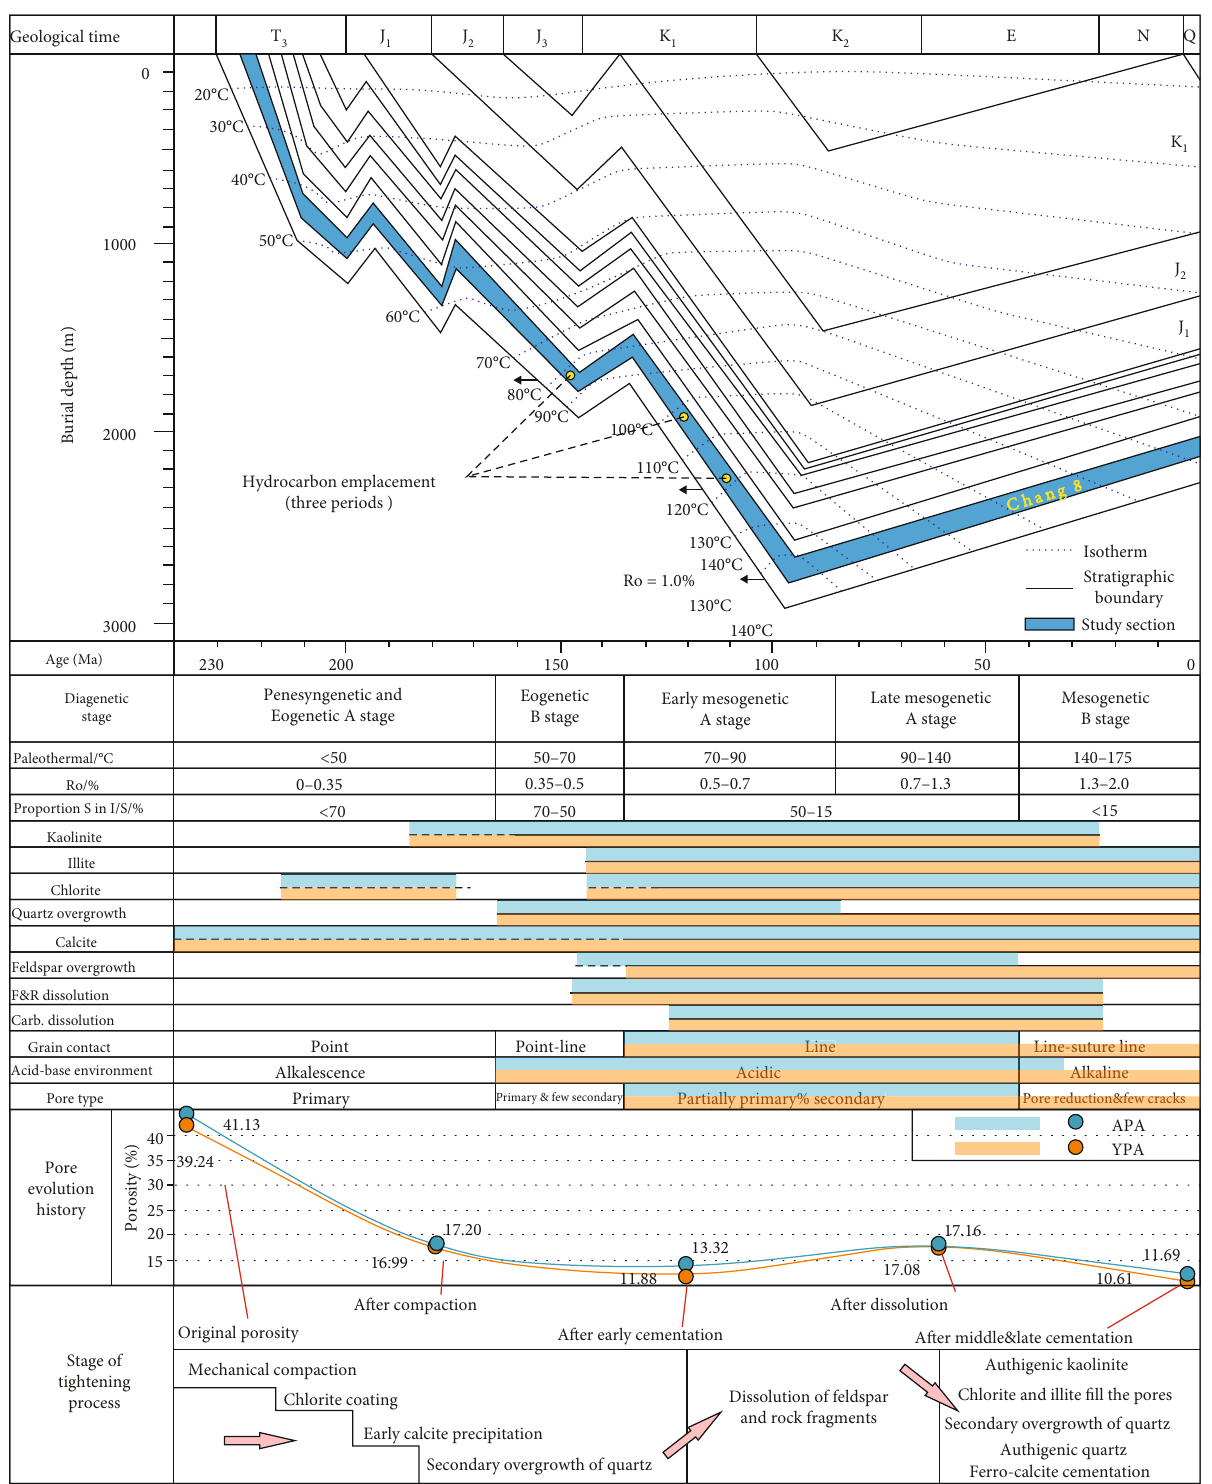
Figure 14: Di ff erences in diagenetic stages and porosity evolution between the YPA and APA of the Chang 8 [10,